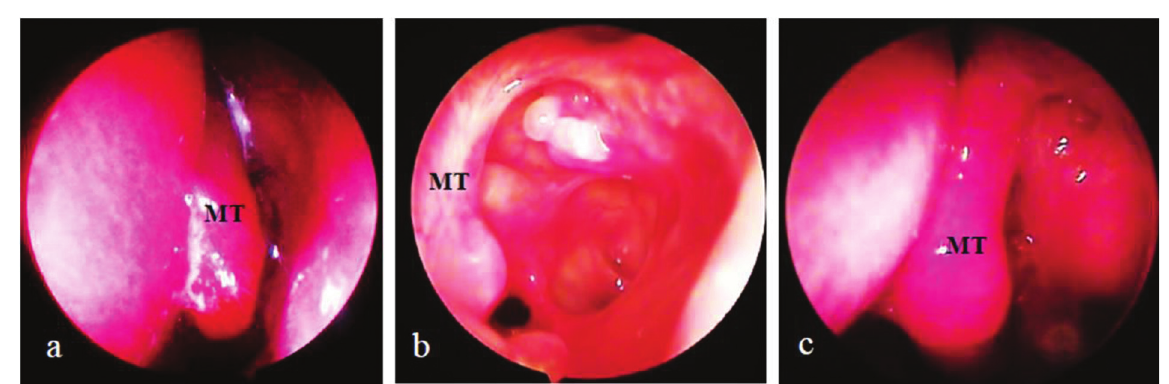
Nasal endoscopy showing: (a) Marked mucosal edema in Gelfoam packed on the left side 1-month postoperatively. (b) Mild mucosal edema in Stammberger ’ s Sinu-Foam packed on the left side 1-month postoperatively. (c) Marked mucosal edema obliterating the middle meatus in Surgiflo packed on the left side 3-month